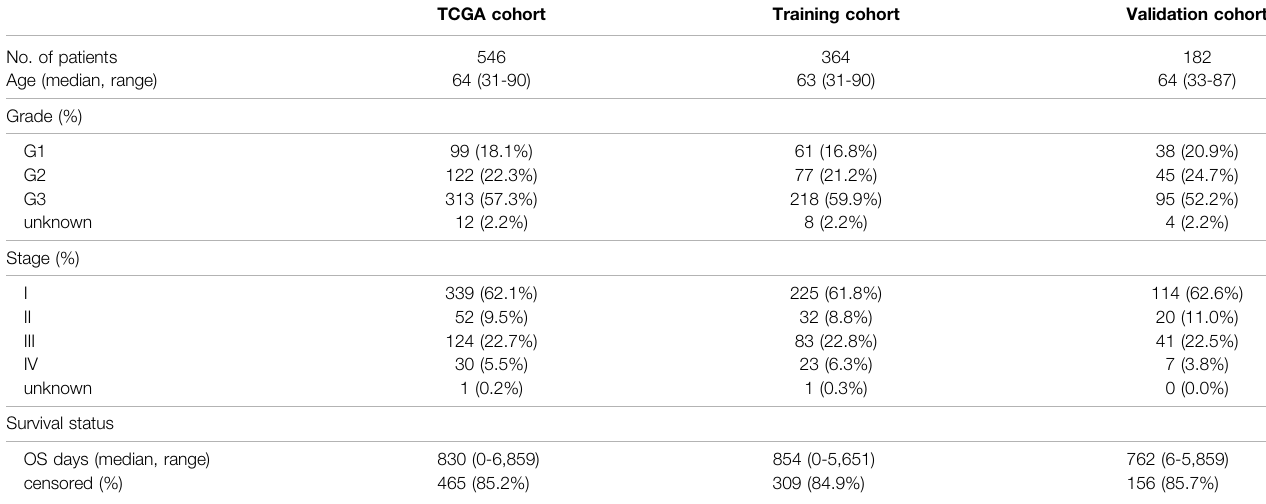
TABLE 1 | clinicopathological features of the EC patients used in this